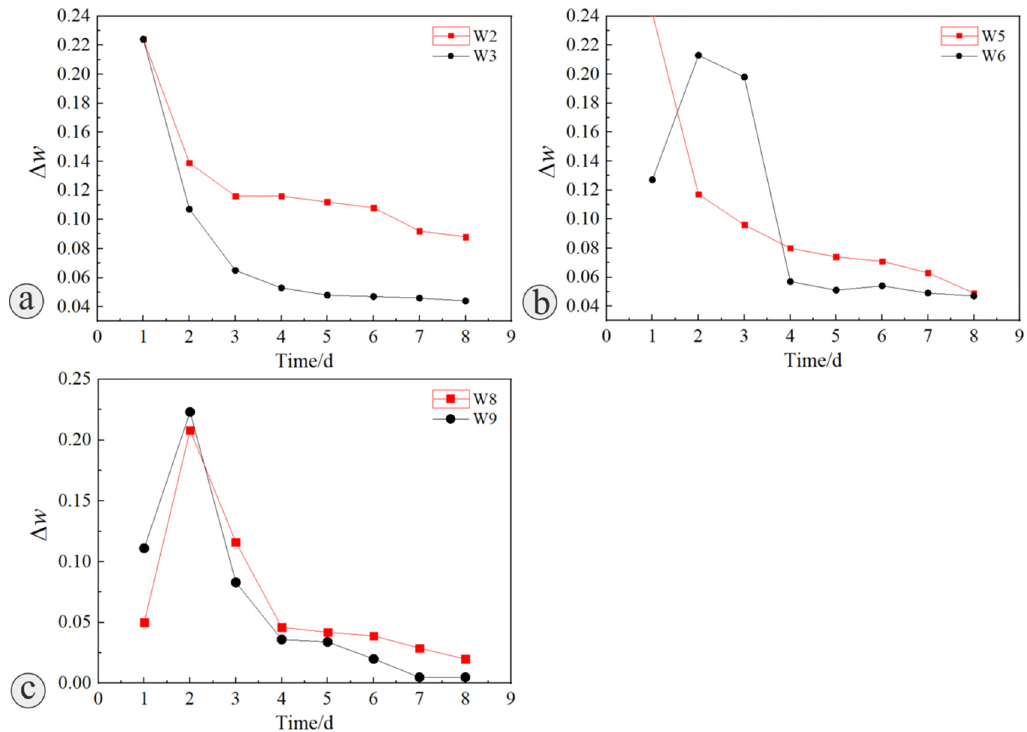
Figure 10. Daily maximum increment of moisture content at different measuring points ( a ) H1 = 1.0 m, ( b ) H2 = 0.8 m and ( c ) H3 = 0.4 m.